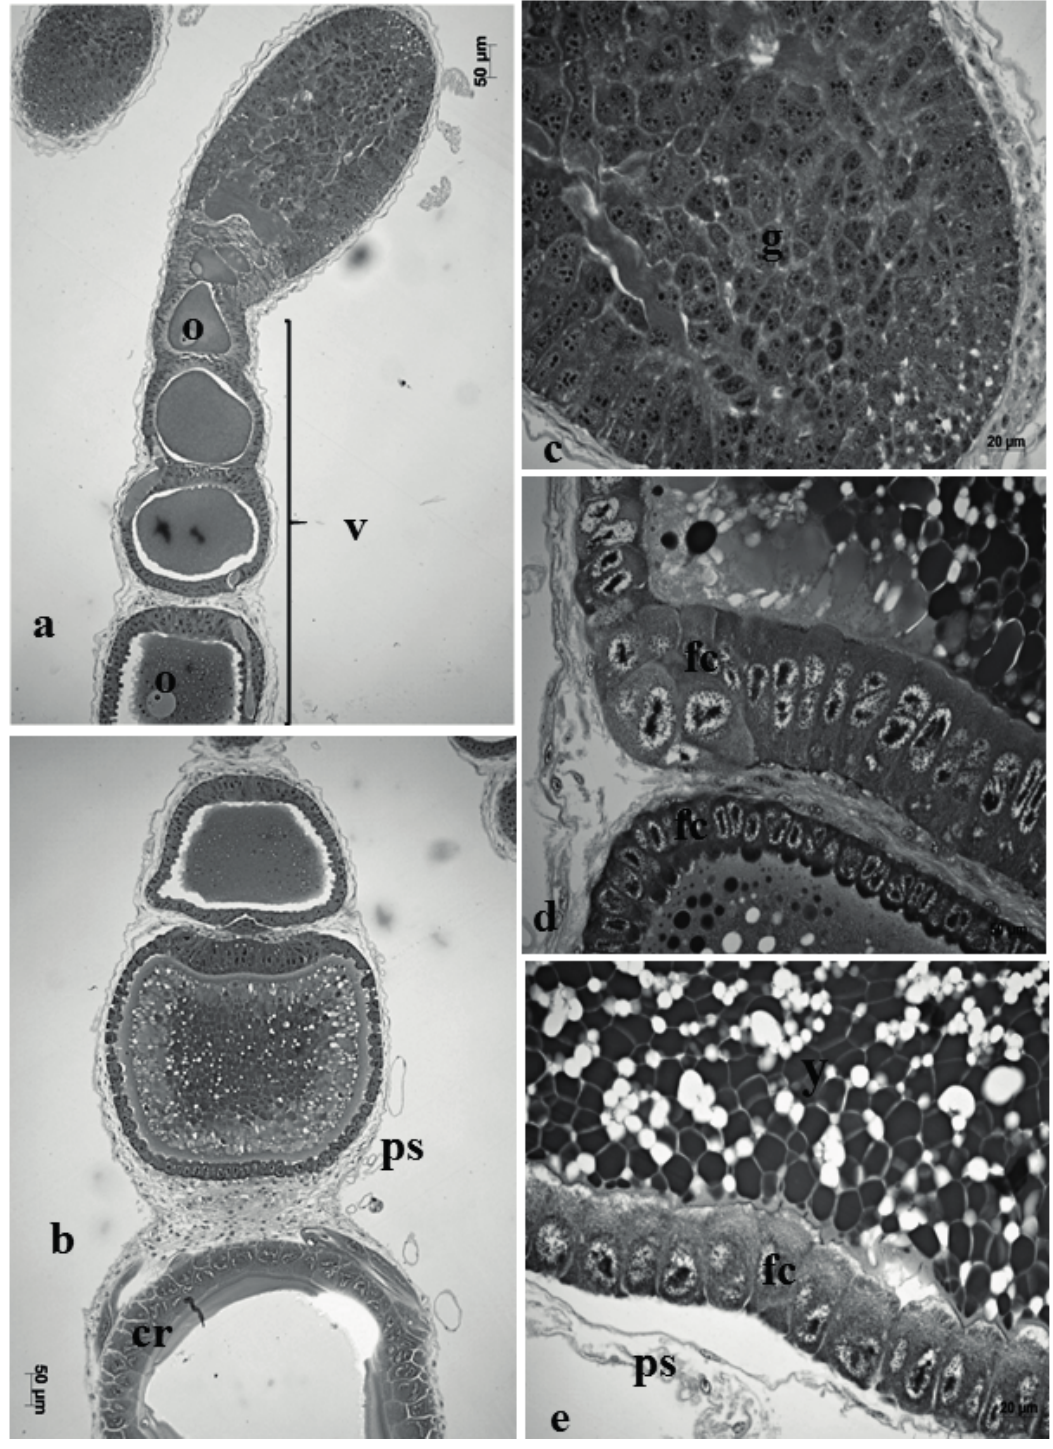
Figure 2 - Longitudinal cut of the ovariole of the predator Podisus nigrispinus (Heteroptera: Pentatomidae) with oocytes at different stages of development. a, b ) oocytes at different stages of development and linear arrangement. c ) Germ region. d, e ) Details of follicle cells at different stages of development. g , germ; o , oocyte; v , vitellary; fc , follicle cells; y , gem; ps , peritoneal layer; cr ,